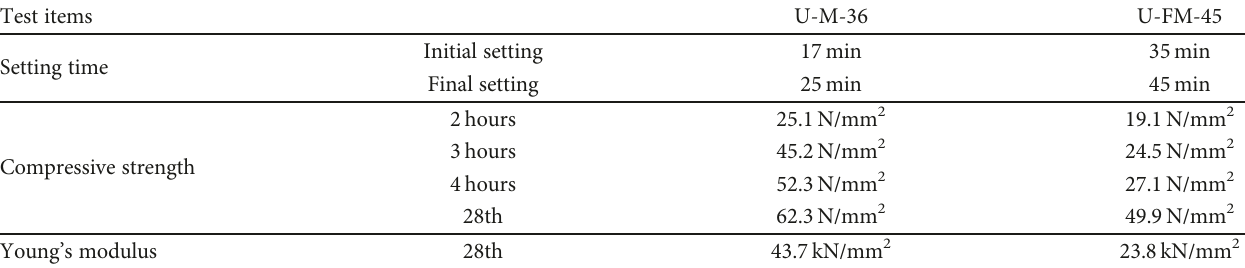
Table 2: Characteristic values of repair